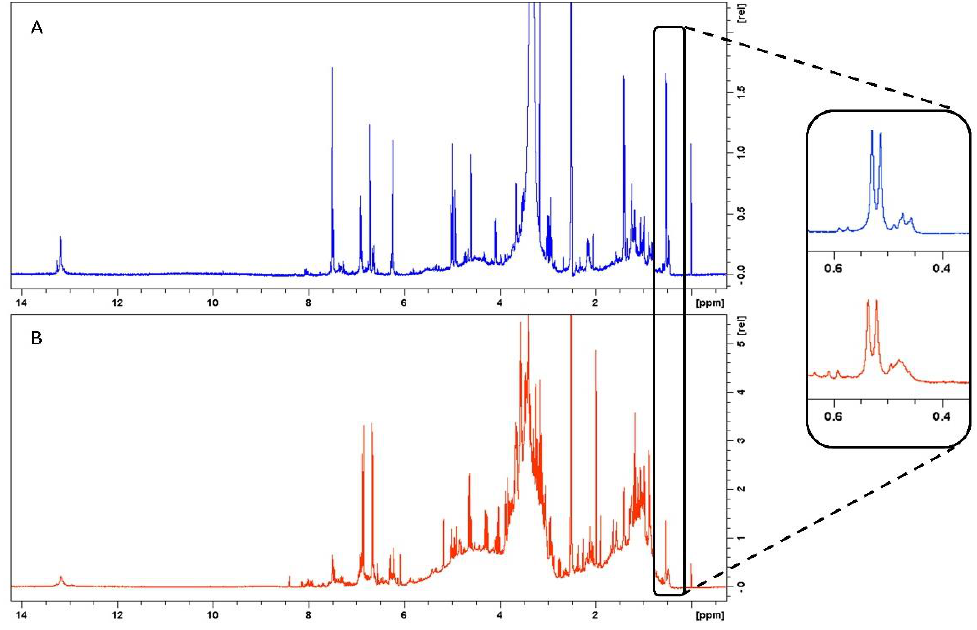
Figure 2. (A ) 1 H-NMR spectrum of hepatodamianol (400 MHz, DMSO- d 6 ). ( B ) 1 H-NMR spectrum of a standardized extract of T. diffusa (25 mg/mL, 400 MHz, DMSO- d 6 ). The outside expansion shows the doublet resonance of hepatodamianol:CH 3 -6 ’’’ in 0.515 ppm; it was used to quantitate this compound.